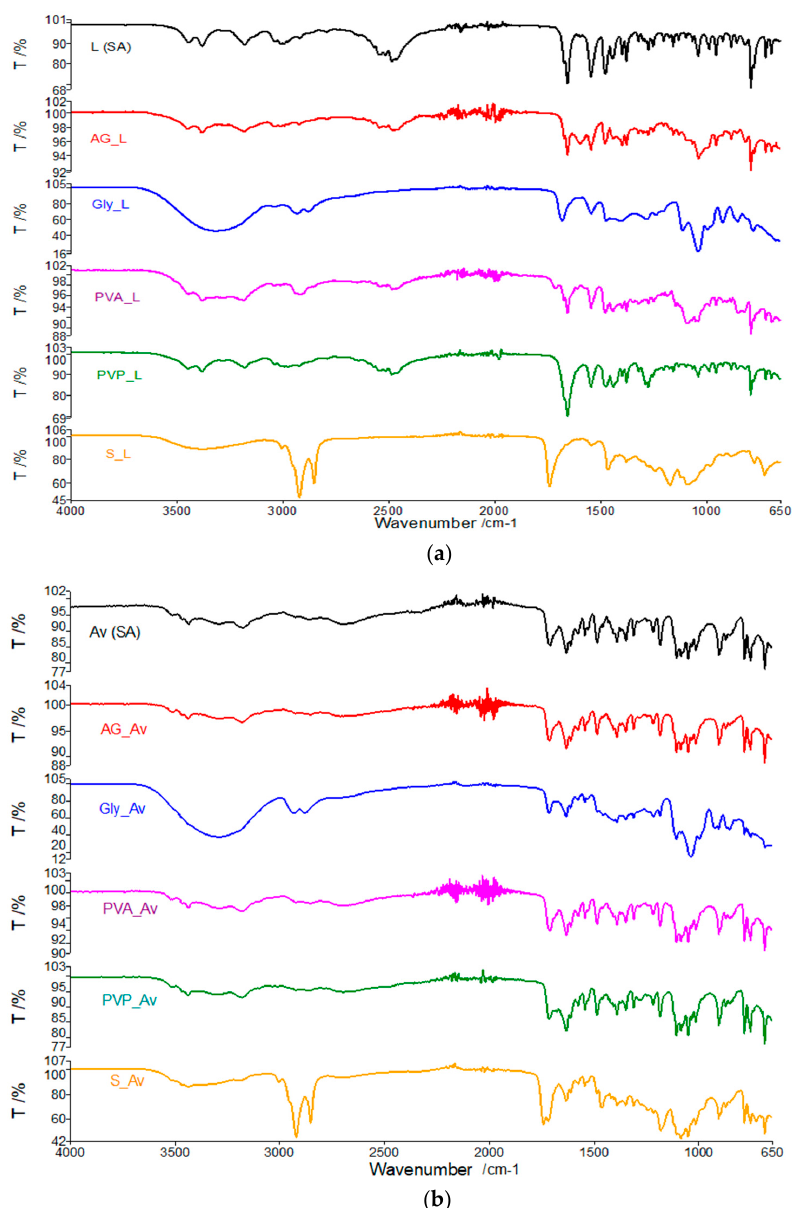
Figure 3. ( a ) FTIR spectra of L (SA) compared to binary mixtures of the active substance with the components used in membrane synthesis (1:1); ( b ) FTIR spectra of Av (SA) compared to binary mixtures of the active substance with the components used in membrane synthesis (1:1). For the binary mixtures obtained between L (SA) and membrane components, it can be observed that for the Gly- L (SA) mixture spectrum, the characteristic bands of the ac- tive substance are not highlighted very well, these being covered by the Gly spectrum. In the case of the binary mixture obtained between Span and L (SA), there are a lack of bands from 1650 cm − 1 related to the CO bond within the carbonyl group. Therefore, a reaction of the Span component with the active substance at the carbonyl bond may be suspected. For the rest of the binary mixtures, the bands characteristic to the active substance can be observed. Analyzing these figures can be seen very clearly in addition to the bands characteris- tic of the components used in membrane synthesis and peaks characteristic to the active substance Av (SA). This statement argues that the active substance Av (SA) does not in- teract with membrane components while in the case of L (SA), and can be considered a possible interaction with Span. 3.1.3. FTIR Study of Synthesized Membranes Within the membranes, the obtained spectra will be compared with the active sub- stances L (D) and Av (D). In order to validate the presence of the active substance Av in the membrane, the main absorption peaks at 3500–3400 cm − 1 (NH), 1695 cm − 1 (C=O), 3282 cm − 1 (NH 2 ), 1478 cm − 1 (C=N) and 1182 cm − 1 (C–N) and in the case of the L substance the presence of peaks from 3400 cm − 1 specific NH bond stretches will be followed, vibration from 3100 cm − 1 (CH), 1680 cm − 1 C=O characteristic for amide I, at 1470 cm − 1 (CN) amide II and at 960 cm − 1 Fingerprint area. It can be easily seen that the bands characteristic of the two active substances are located in the same spectral areas [34,35]. Analyzing the overlapping curves of Av and L with the membranes’ spectra based on alginate and glycerol (Figure 4a), we can say that both individual and mixed mem- branes with lidocaine and acyclovir present the representative peaks of acyclovir, but these are easily visible in the FTIR spectrum of membranes. Here, it is essential to mention